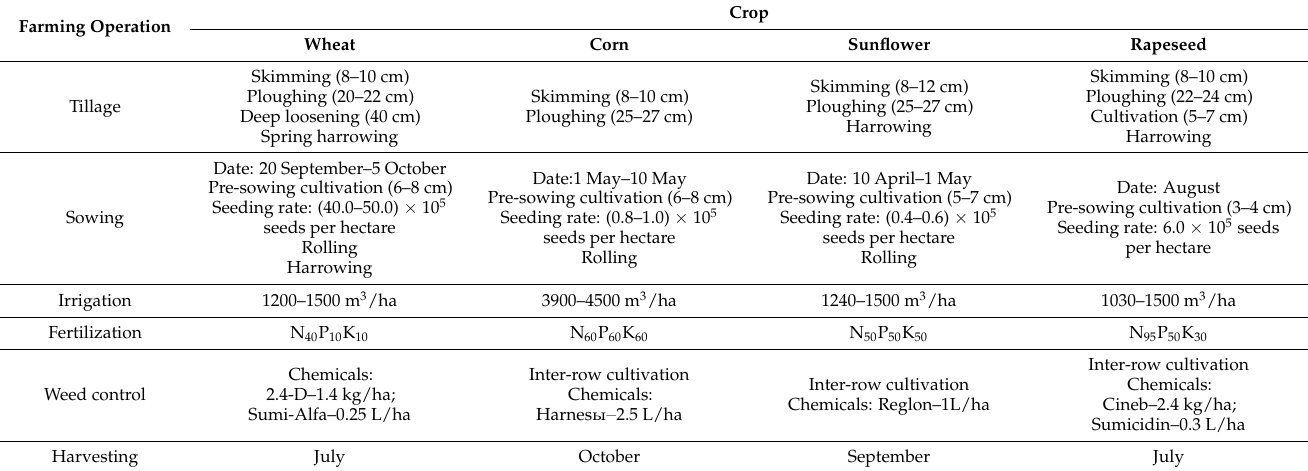
Table 2. Agricultural